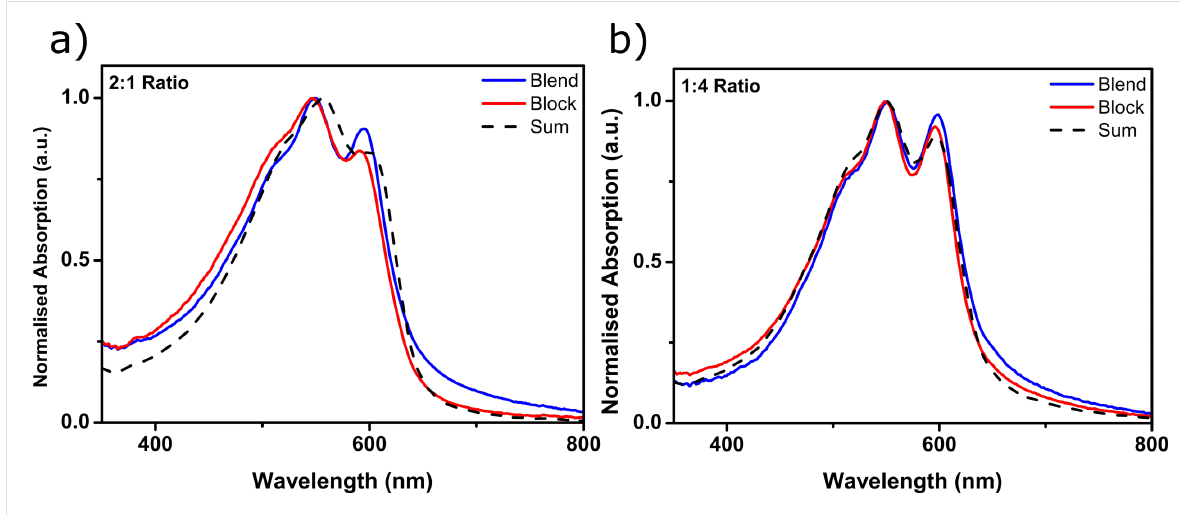
Figure 3: Thin film UV–visible absorption spectra of 2:1 (a) and 1:4 (b) P3OT- b -F-P3OT polymers (red line), overlaid with the UV–visible absorption spectra of a blend of P3OT and F-P3OT in the same ratio (blue line). The dotted line indicates the corresponding sum of the UV–visible absorption of P3OT and F-P3OT, weighted according to the composition. Thin films were spin cast from hot